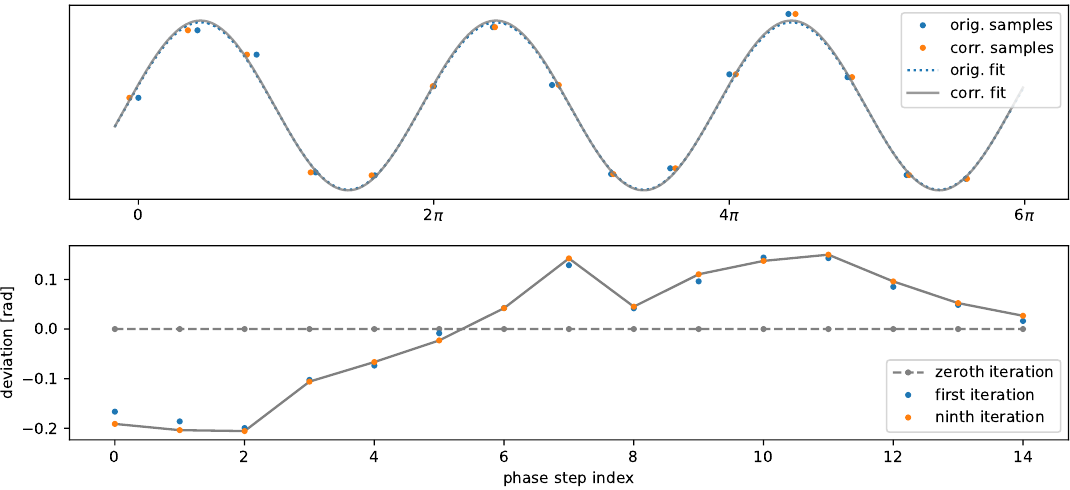
Figure 7. Above: An example phase stepping curve consisting of 15 steps over three grating periods. Sampled values are shown both at the originally intended as well as at the inferred sampling positions (blue and orange markers respectively) along with the corresponding initial and corrected sinusoid fits. Although the difference in the resulting fit appears small, it is clearly noticeable in the final images, as shown in Figure 8. Below: Deviations of the phase stepping series’ sampling positions from the intended ones in units of radians as found at 0, 1 and 9 iterations of Algorithm 1. The range of deviations corresponds to roughly ± 10% of the intended stepping increments of 2